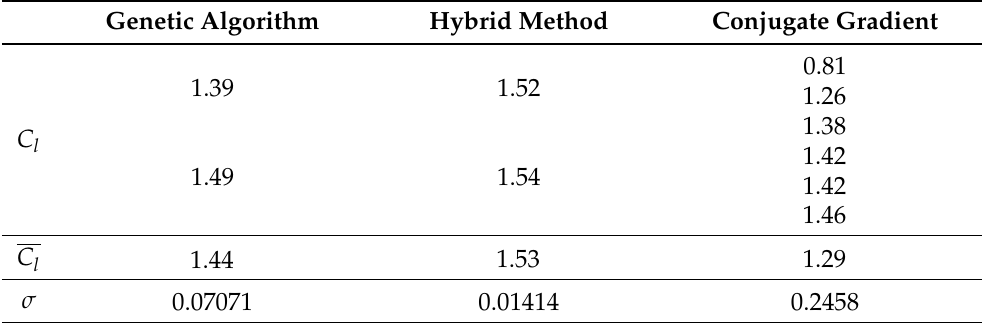
Table 4. Best lift coefficient of each optimization case, means and standard deviation.